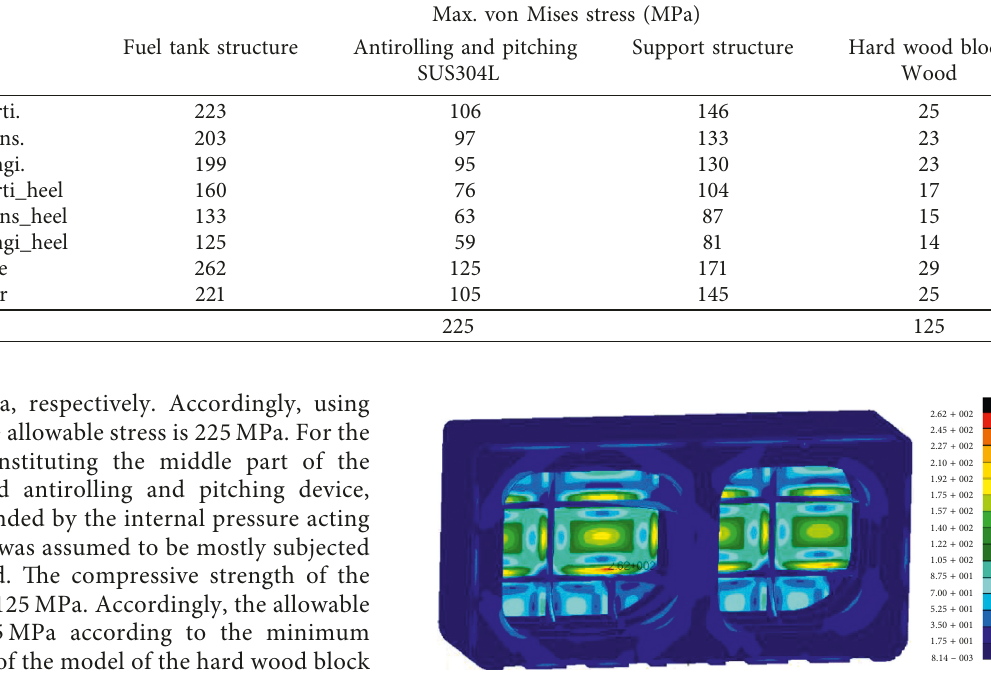
Figure 9: Structural analysis results on equivalent stress distri- bution of the LNG fuel tank.